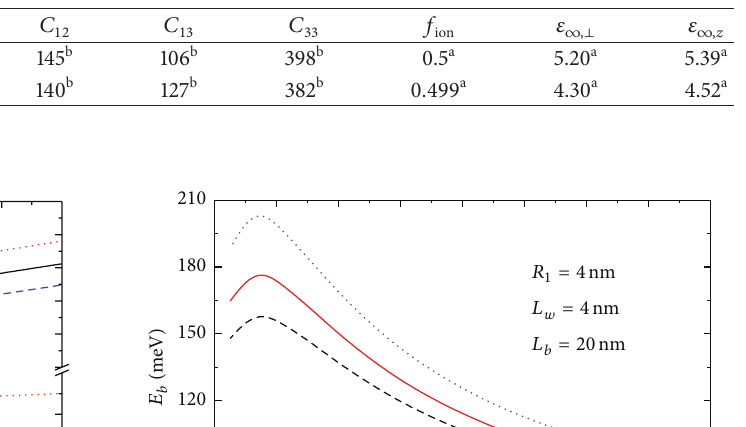
Table 2: Band gaps 𝐸 𝑔 (in units of eV), spontaneous polarization (in units of C/m 2 ), elastic constants 𝐶 11 , 𝐶 12 , 𝐶 13 , and 𝐶 33 (in units of GPa), , and the high frequency dielectric constant 𝜀 ∞ . Phillips iconicity parameter 𝑓 ion